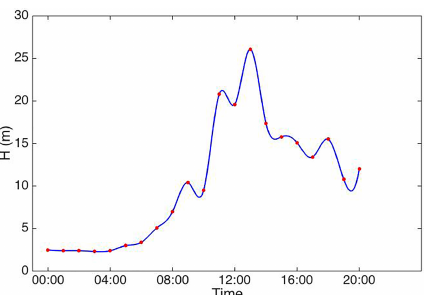
Figure 12. Maximum wave height recordings at the Kinsale Energy gas platform during Storm Ophelia on 16 October 2017. A 26 . 1m wave was recorded. Data courtesy of Emily Gleeson at Met Éireann.